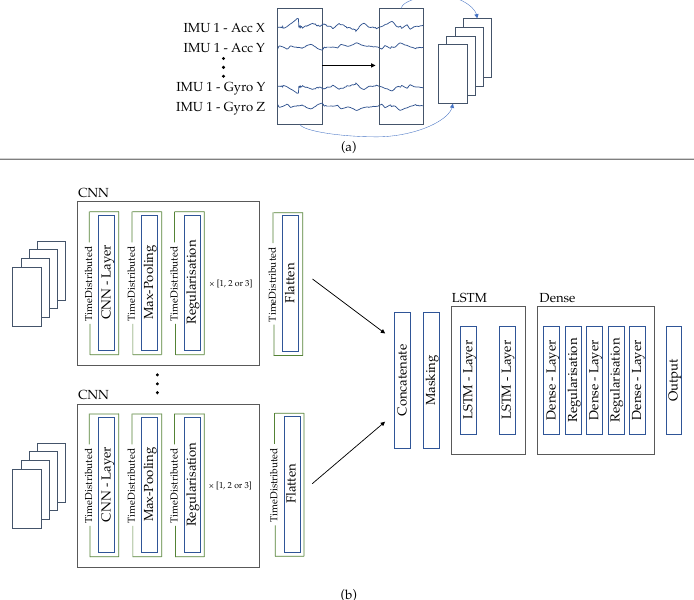
Figure 6. ( a ) Input definition for the tested “IMU-centric” approach. ( b ) Network architecture of the “IMU-centric”